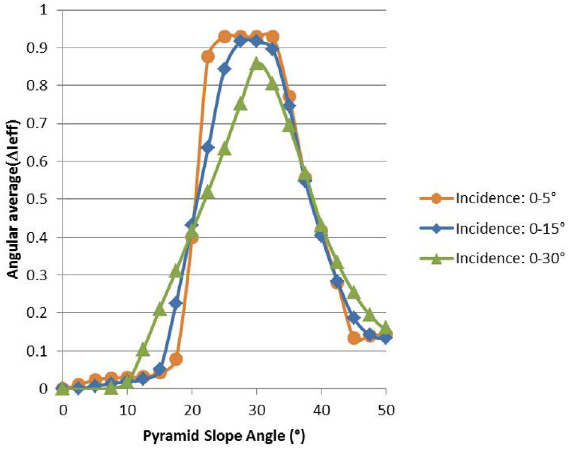
Fig. 7. Simulated different slope